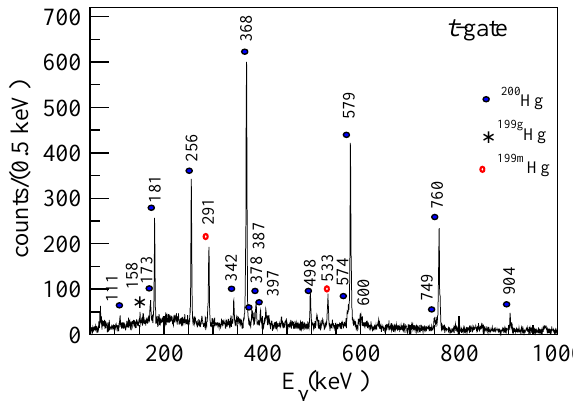
Fig. 5. (color on line) Prompt γ -ray spectra for E lab = 45 MeV obtained in coincidence with outgoing fragments t . The γ -ray transitions originating from the residues from capture of 4 He are labeled.